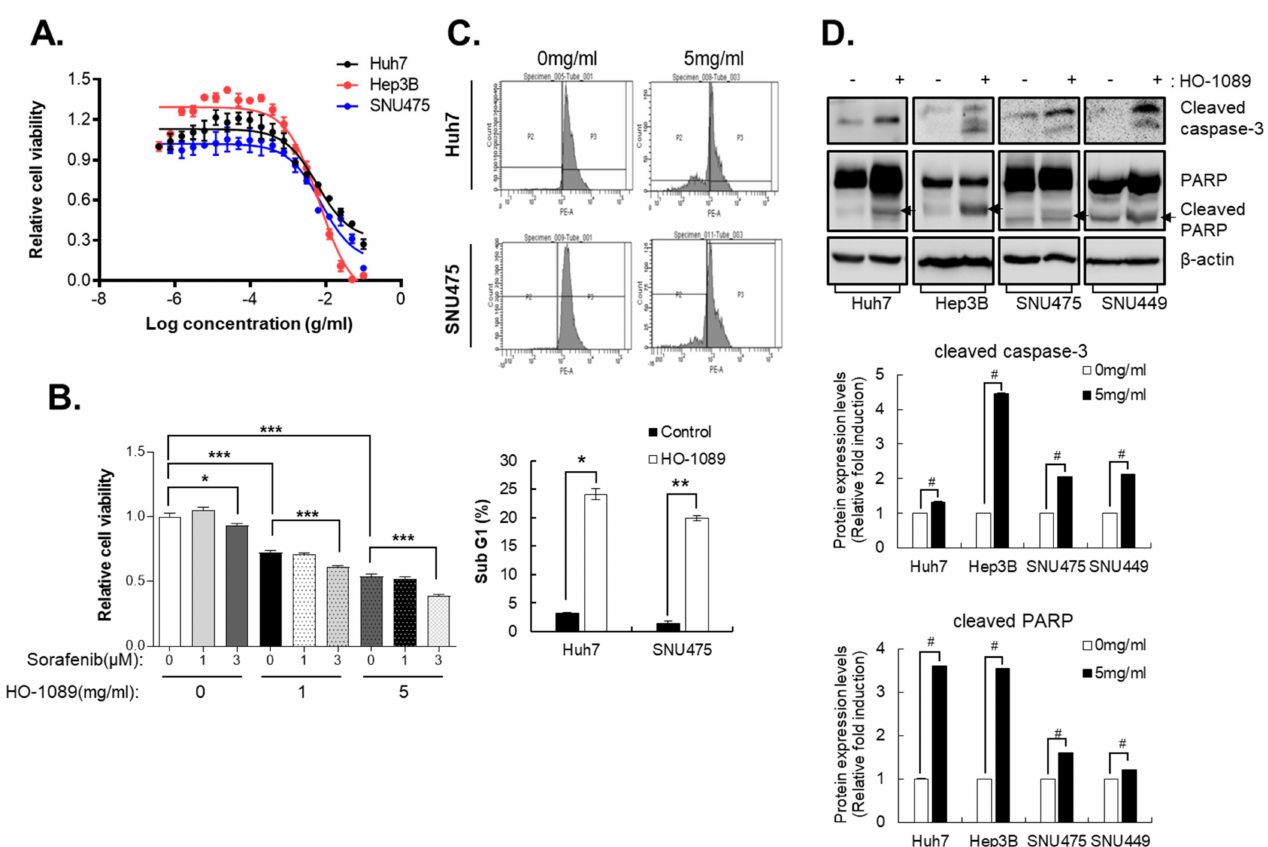
Figure 1. Apoptosis induced by HO-1089 treatment. ( A ) Huh7, Hep3B, and SNU475 cells were treated with HO-1089 for 48 h beginning with 50 mg/mL and using sequential 2-fold serial dilutions. Cell viability was measured by the number of cell nuclei. ( B ) The viability of Huh7 cells treated